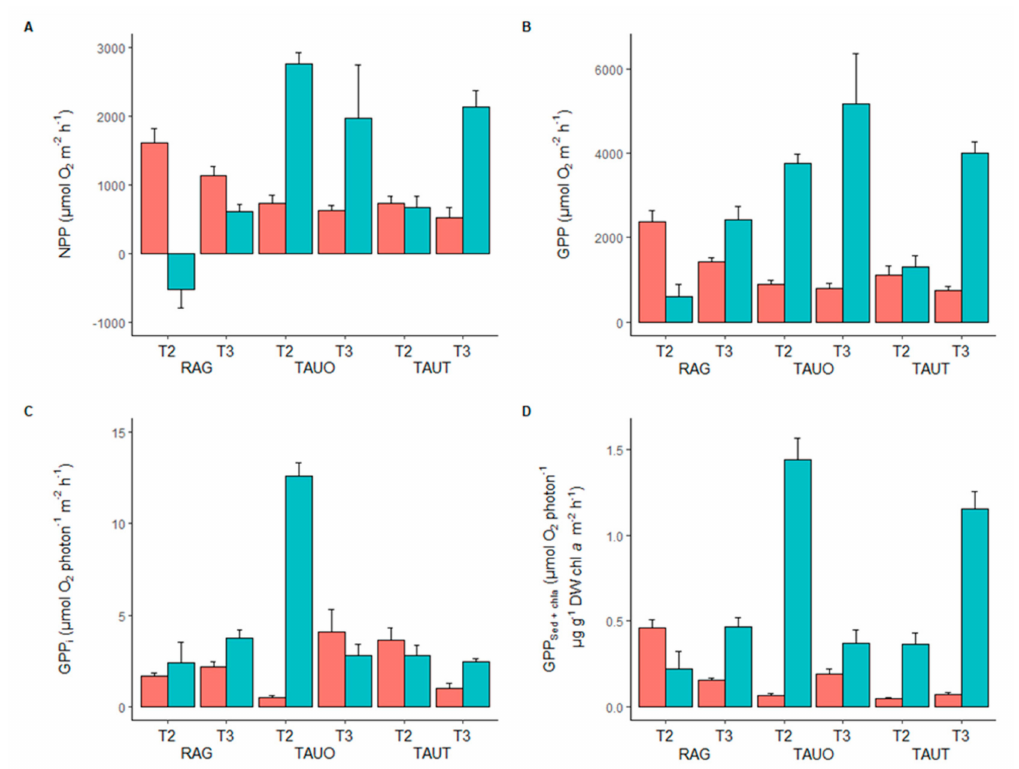
Figure 5. Net primary production (NPP) ( A ), gross primary production (GPP) ( B ), gross primary production corrected by PAR i (GPP i ) ( C ), and gross primary production corrected by PAR Sed and photosynthetic biomass (sediment chl a content) (GPP Sed + chla ) ( D ), during emerged (red) and submerged (blue) tidal state in June (T2) and November 2018 (T3). Bars represent means (n = 9) with standard error bars